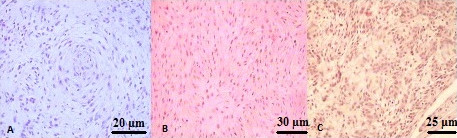
A: The cells are in disorganized fascicles with pleomorhism, nuclear atypia and neoplastic spindle cells with wavy eosinophilic cytoplasmic processes. (H & E; bar 20 μm; ×400). B: the neoplastic cells form dense bundles separated by scanty collagenous stroma. Notice bland nuclei lacking atypia. (H & E; bar 30 μm; × 400) C: Upon histopathological examination of the ulnar mass, neurofibroma with a mixture of round and spindle shaped cells, mitotic figures, infiltrates of various numbers of lymphocytes and hypercellularity arrangement was diagnosed. (H & E; bar 25 μm; × 400).